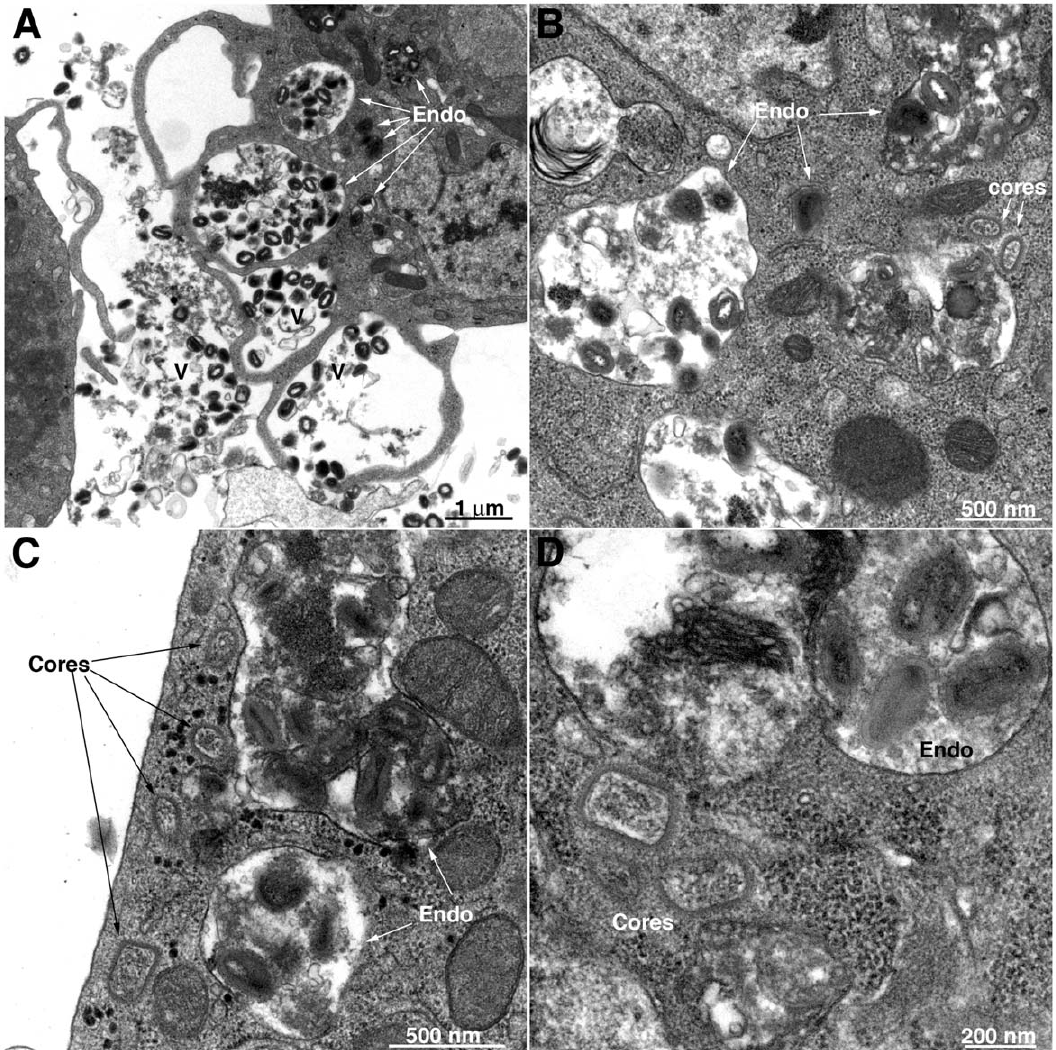
Figure 4. Transmission electron microscopy of VACV infected S2 cells. Purified VACV virions were spinoculated onto cells for 1 h at 4 u C at a MOI of 150 PFU per cell. The cells were then incubated at 31 u C. A ) Low magnification of virions associated with cells and in endosomes at 1 h after infection. B–D ) Higher magnifications showing virions in vesicles and cores in the cytoplasm at 1 h after infection. V, virions; Endo, endosome. A size marker is present at the lower right corner of each panel.